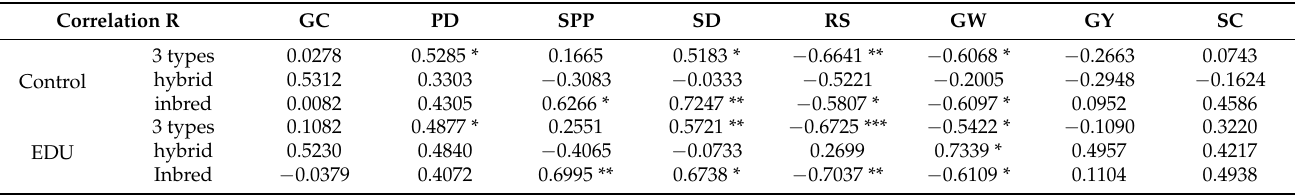
Figure 2. Grain nitrogen plotted against grain weight and grain number. GN, GW, SD, and EDU stand for grain nitrogen concentration, grain weight, spikelet density (grain number), and ethylenediurea application. GN and GW under control ( a ) and EDU ( c ) treatment across three types of rice cultivars, and separated by the hybrid and inbred cultivars under control ( e ) and EDU ( g ). GN and SD under control ( b ) and EDU ( d ) treatment across three types of rice cultivars, and separated by the hybrid and inbred cultivars under control ( f ) and EDU ( h ). Solid and dashed lines indicate simple linear regressions. Table 3. Correlation of grain nitrogen with grain carbon concentration (GC), panicle density(PD), spikelet number per panicle(SPP), spikelet density (SD), percentage of ripened spikelet (RS), grain weight (GW), grain yield (GY), and sink capacity